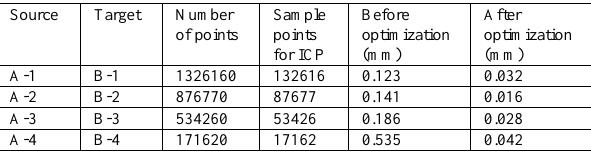
Table 3. Numbers of matching pairs for CCICP